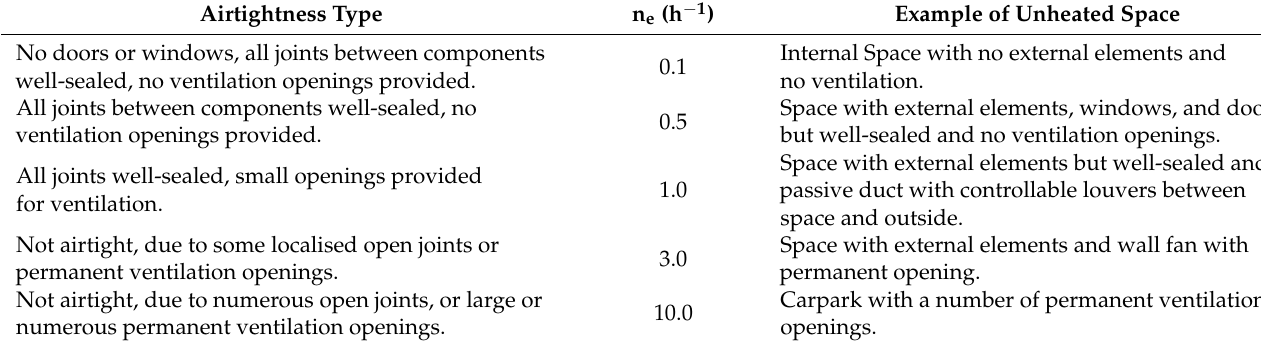
Table 1. Conventional air change rates between the UnSp and the EXT (adapted from [8]). Airtightness